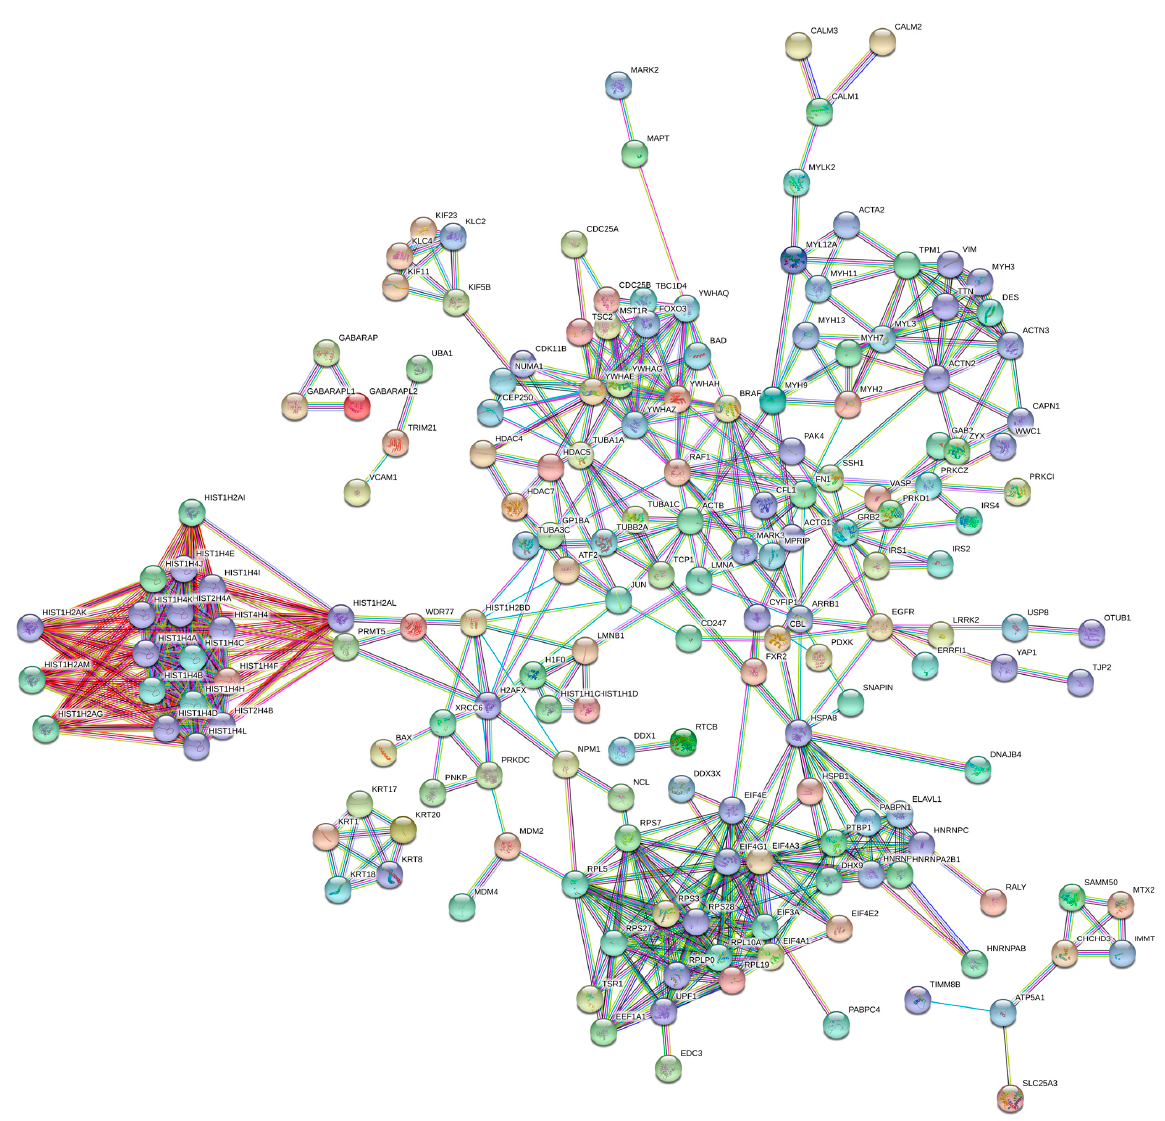
Figure 2. Protein–protein interaction (PPI) network of up-regulated proteins in BRAFV600E mutant HT-29 colon cancer cells and their interaction partners retrieved from the DAVID functional enrichment tool. The PPI network was constructed using the STRING database of known and predicted protein–protein interactions with the highest confidence of 0.900.